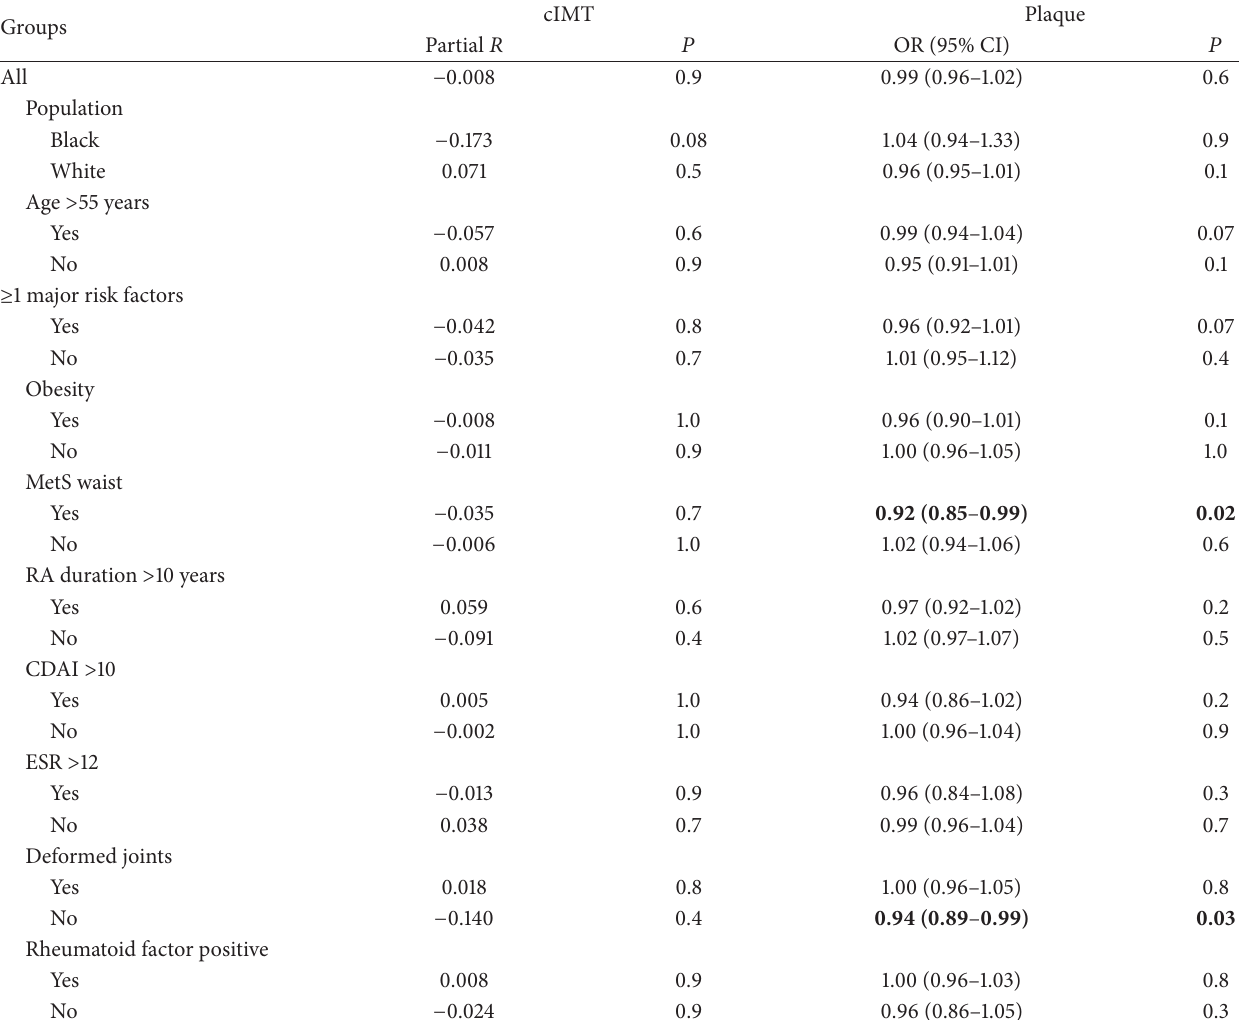
Table 4: Independent relationships of high molecular weight adiponectin concentrations (1 SD increment) with carotid atherosclerosis in all RA patients and